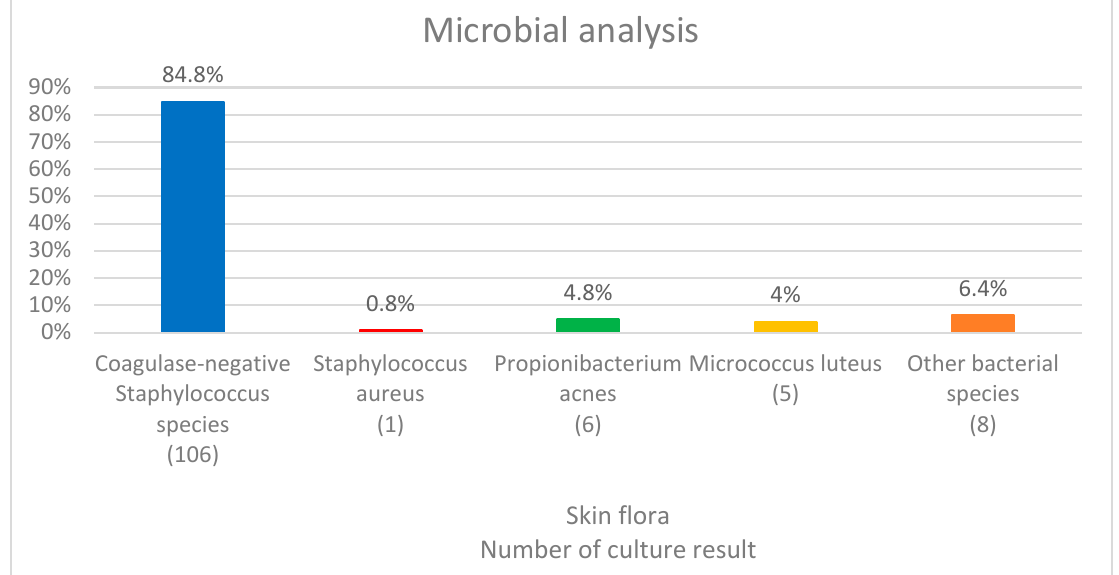
Figure 2. Microbial analysis of nipple/areola complex after disinfection.